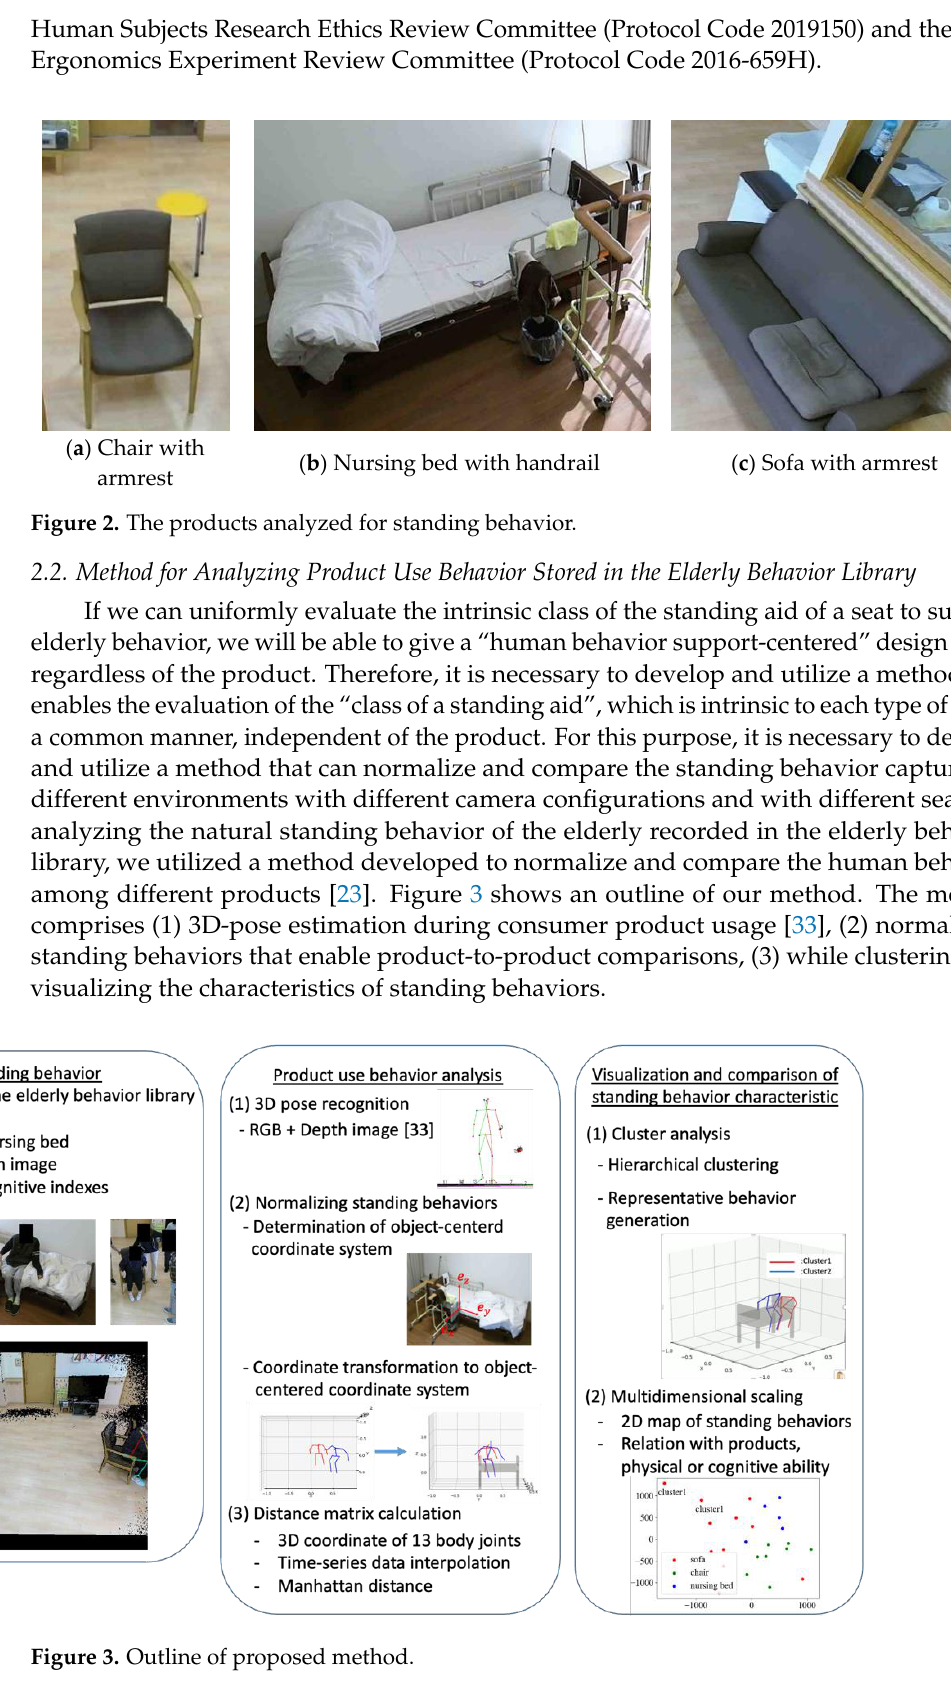
( c ) Depth image Figure 1. Example of installation of Kinect in a living room in a nursing home and captured RGB and depth image. This study analyzed consumer product use behavior in various standing behaviors recorded in an elderly behavior library. In this study, we analyzed 24 cases of standing behaviors of six participants from the elderly behavior library, which narrowed down to all standing behaviors from a sofa, a chair, and a nursing bed, and whose whole-body postures were successfully extracted. Table 1 lists the sex and age of the participants, phys- ical ability index of the elderly based on the BI, cognitive ability index based on the MMSE (Appendix A), and seat type utilized by the participants during the standing behavior. It is worth noting that the ID in Table 1 is similar to that recorded in the elderly behavior library.